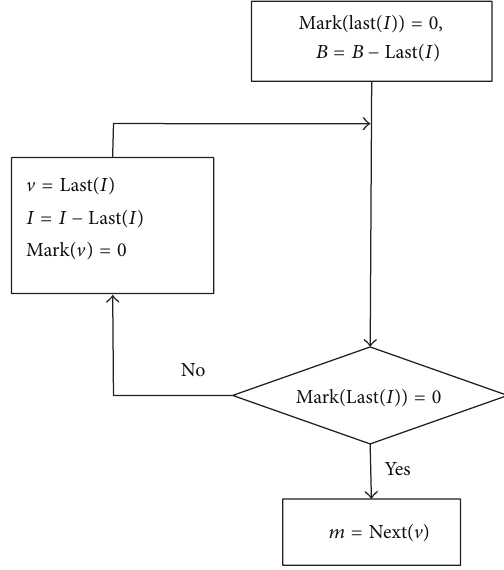
Figure 8: Flowchart of the process of backtracking vertices.